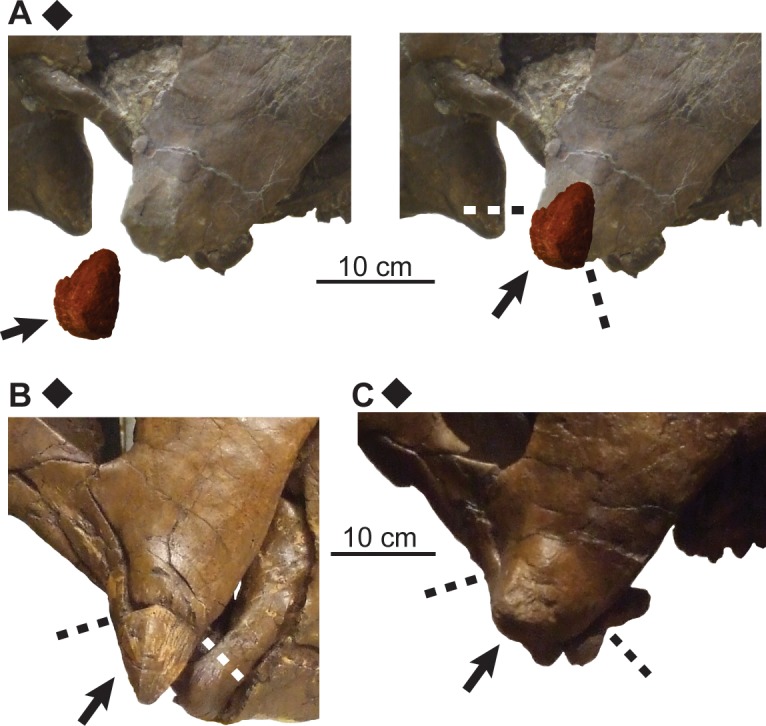
Ontogenetic changes in epijugal of Chasmosaurus.Articulation of epijugal with jugal and quadratojugal (character 11): (A) epijugal disarticulated (UALVP 40), (B) epijugal articulated with open suture (ROM 839) and (C) epijugal articulated with closed suture (TMP 1981.019.0175). Arrows = epijugals; dashed lines = sutural contacts. Chasmosaurus sp. (diamonds). [planned for column width].